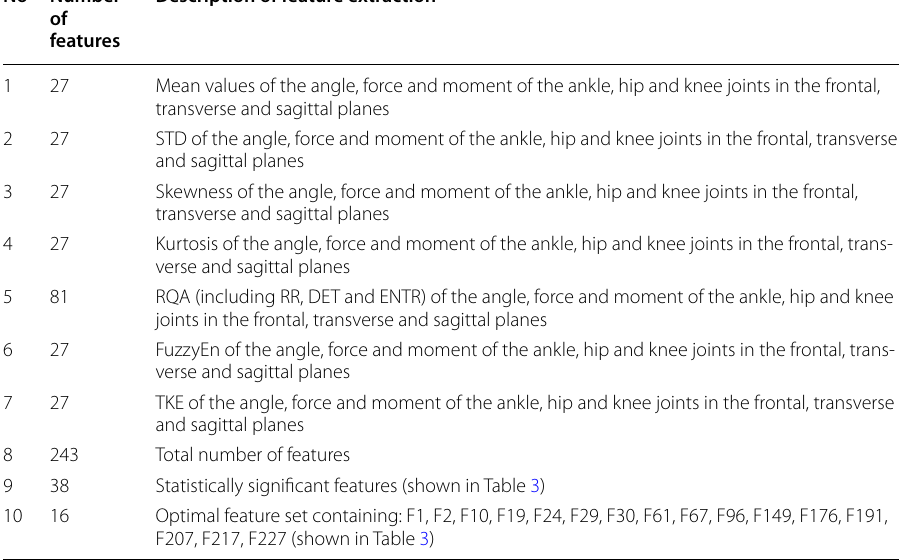
Table 2 Description of feature extraction No Number